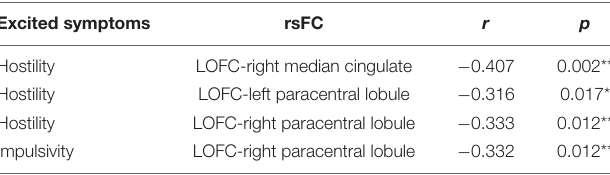
TABLE 6 | Correlations between the rsFC values and PANSS excited subscale scores in patients with FES. Excited symptoms rsFC r p Hostility LOFC-right median cingulate − 0.407 0.002** Hostility LOFC-left paracentral lobule − 0.316 0.017* Hostility LOFC-right paracentral lobule − 0.333 0.012** Impulsivity